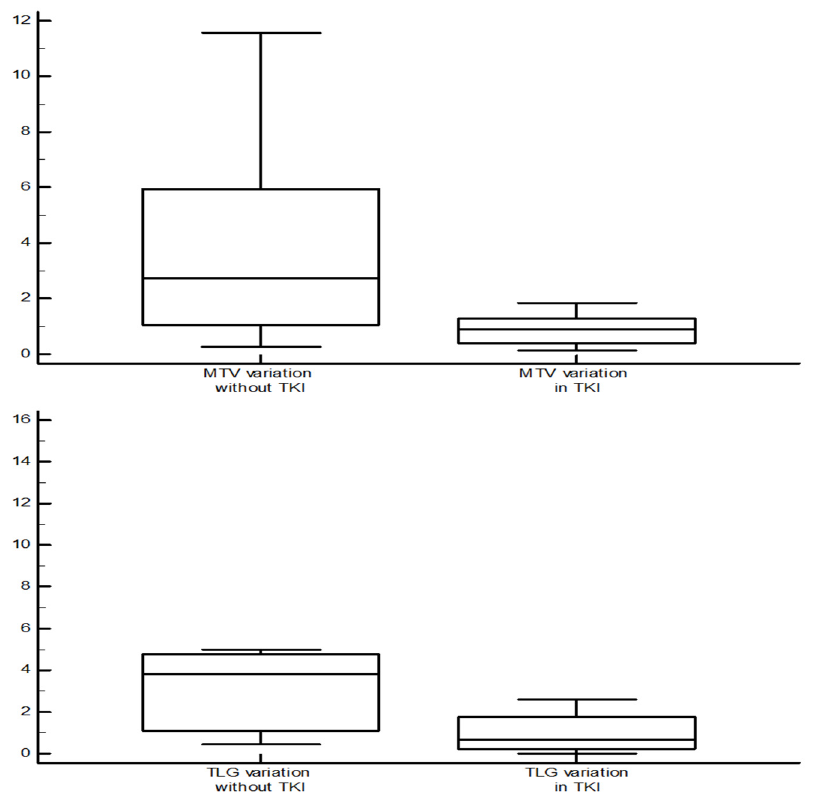
Figure 3. Comparison of MTV and TLG variation (value at the subsequent evaluation/value at the previous evaluation) between the scan performed during tyrosine-kinases inhibitors therapy and those without systemic therapy. In the first group, both MTV and TLG showed a trend of reduction, while in the second one it tended to increase (Mann–Whitney test, median 0.88 vs. 2.73 cm 3 , p = 0.045, for MTV; median 0.65 vs. 4.01, p = 0.013 for TLG).